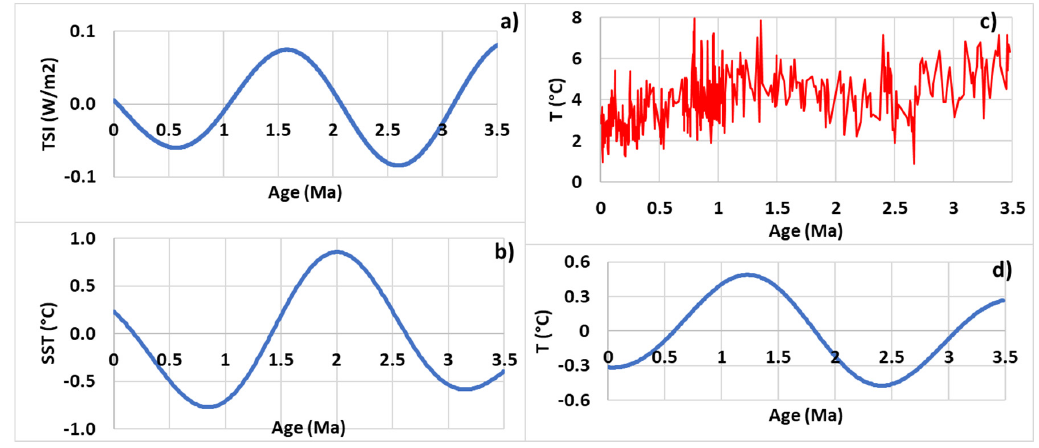
Figure 6. Orbital forcing and responses of SST and sea water temperature (T) into the band 1769–3500 Ka—( a ) Total Solar Irradiance (TSI)—( b ) SST de-trended and filtered—( c ) Benthic foraminiferal Mg/Ca analysis vs. time at DSDP Site 593 used as a proxy of T—( d ) T de-trended and filtered.